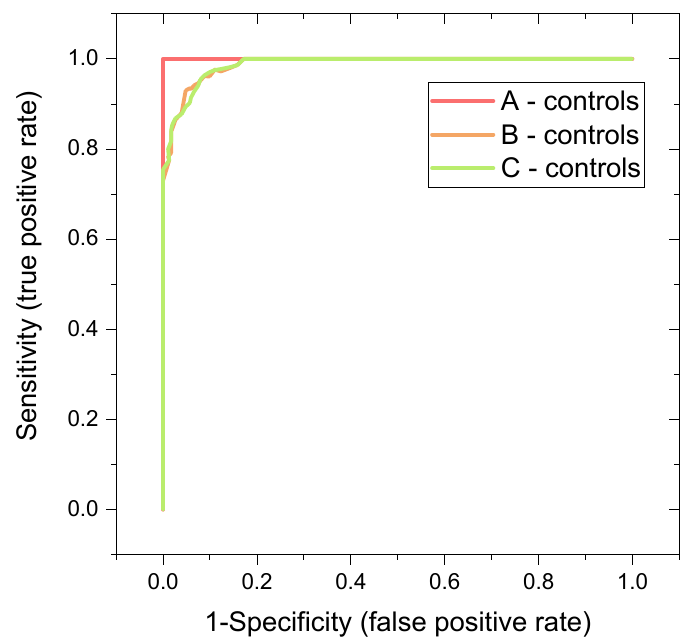
Figure 4. ROC curves derived from random forest discriminatory analysis for binary systems: patients in various sampling times versus controls: A-First day of hospital admission, B-In average 7 days after hospital admission. C-In average 42 days after hospital admission, relative concentrations of plasma metabolites were used as input variables. All evaluated metabolites were used as input variables; more details in Table 2.